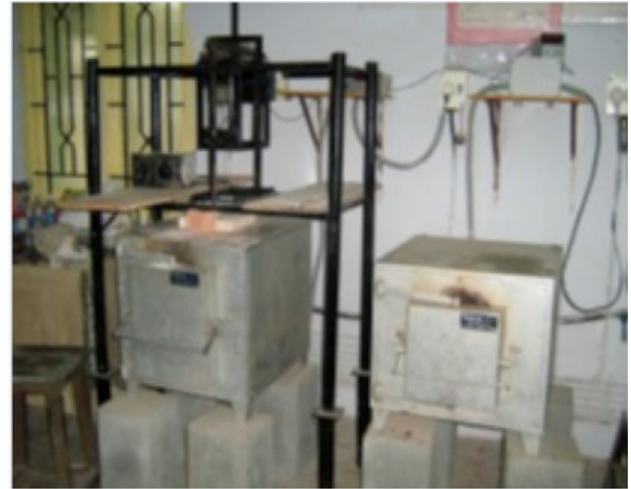
Fig. 3. Fabrication of LM6 alloy using stir casting